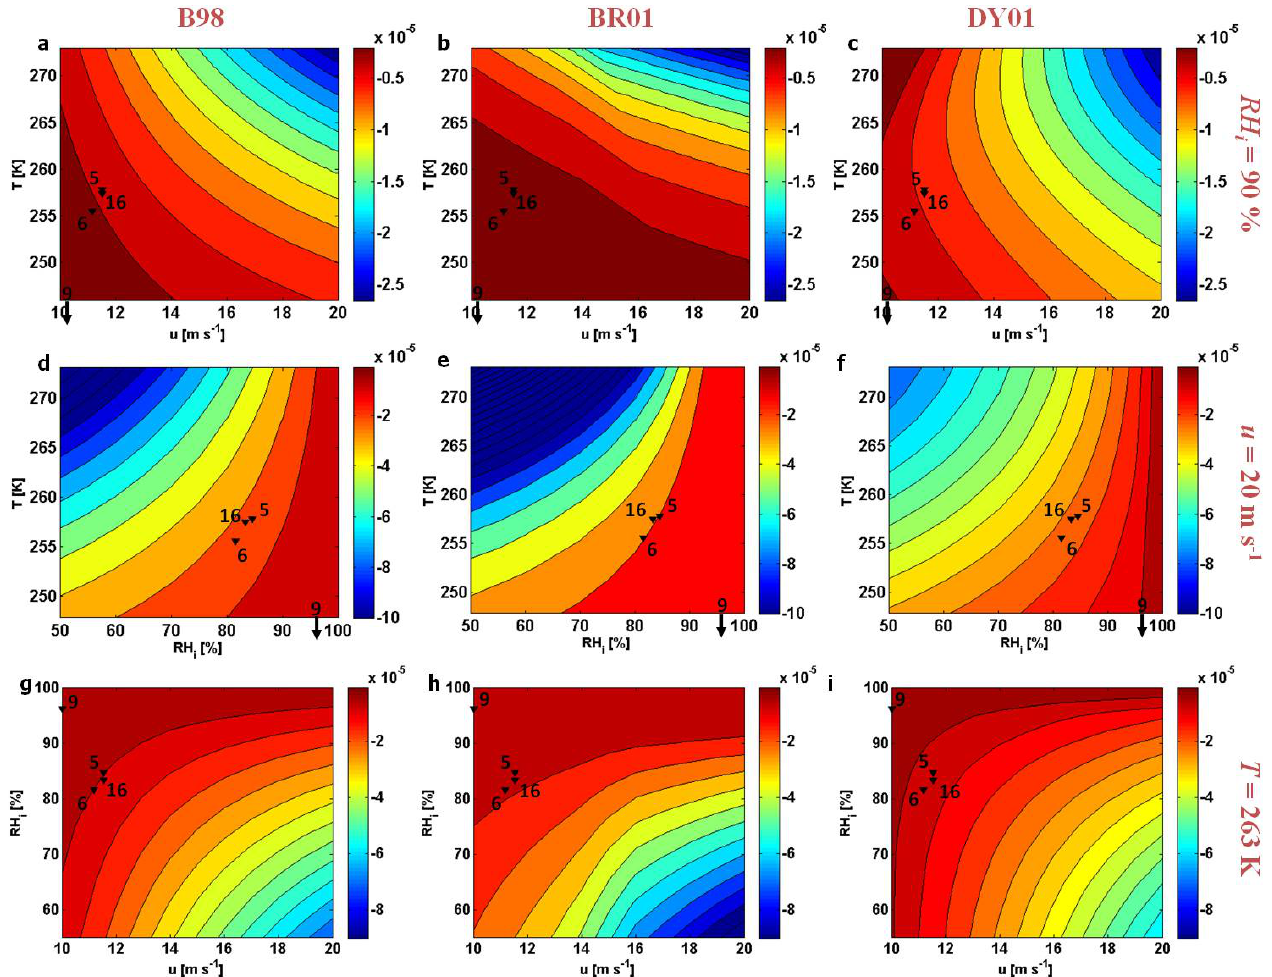
Fig. 8. SU ds rates (kgm − 2 s − 1 ) from 3 sensitivity experiments, with (a–c) relative humidity with respect to ice RH i = 90%, (d–f) wind speed u = 20ms − 1 , and (g–i) air temperature T = 263K, each one conducted for B98 (left panels), BR01 (central panels), and DY01 (right panels), respectively. Mean values for RH i , u and T were calculated for AWS 5, 6, 9 and 16 for snowdrift conditions and used to plot each